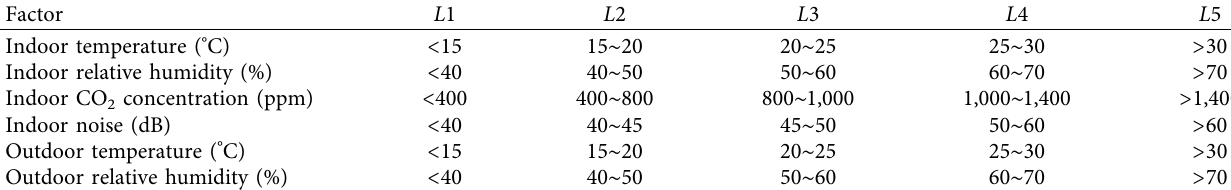
Table 3: Division of factors influencing window opening